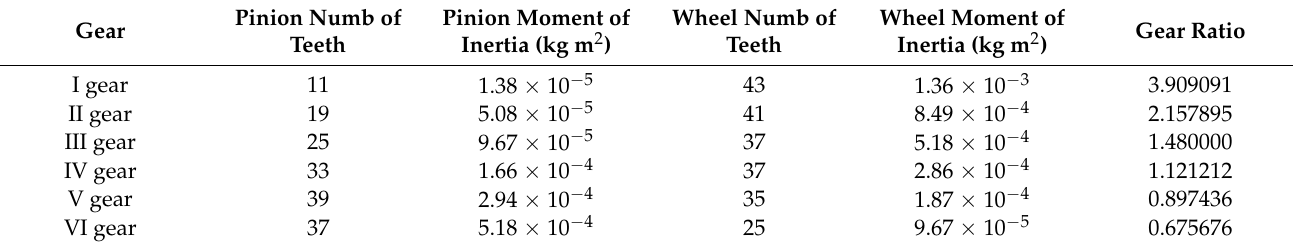
Table A1. Numerical values of DCT.